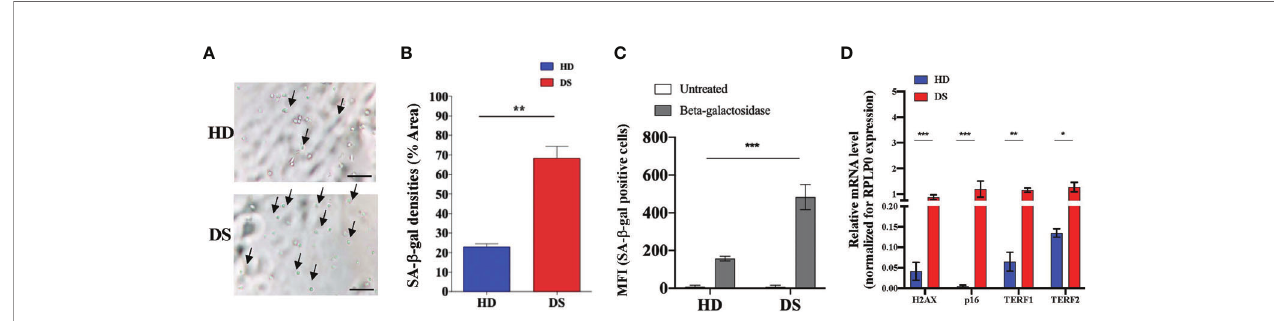
FIGURE 3 | Senescence detection in thymic epithelial cells. (A – C) SA- b -gal staining in TEC isolated from DS patients and age-matched HDs. Analyses performed by microscopy (A, B) (SA- b -gal + cell counts were normalized per % of Area; scale bar = 100 µm) and fl ow cytometry (C) (HD, n = 9; DS, n = 9; HD 2-5 months: 1,35; 5-9 months: 4,6,9 and 2-5 years 2,7,10 referring to Supplemental Table 2 ; while DS 2-5 months: 2,3,5; 5-9 months: 4,8,9 and 2-5 years 1,6, 10 referring to Supplemental Table 3 ). (D) Comparison of mRNA expression of senescence-associated genes (H2AX, p16, TERF1 and TERF2 in thymic tissue from DS patients and age-matched HDs, normalized for the expression of the housekeeping gene RPLP0 (HD, n = 12, sample 13 in Supplemental Table 2 was excluded from the analyses; DS, n = 9, from sample 1 to sample 9 in Supplemental Table 2 ). Mean ± SEM are represented (Mann-Whitney test; * p -value < 0.05; ** p -value < 0.002; *** p -value